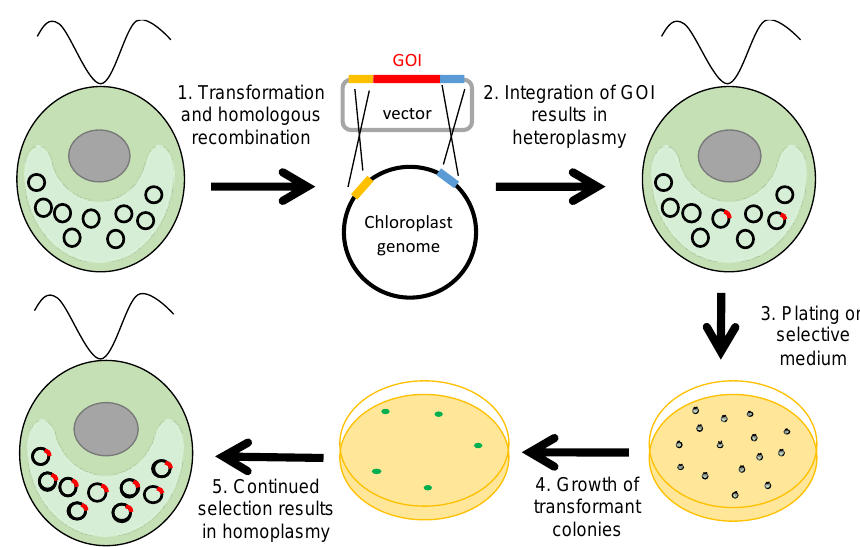
Figure 1. C. reinhardtii chloroplast transformation. The gene of interest (GOI) is integrated into some of the copies of the plastome by homologous recombination. Only cells containing at least one copy of the transgene and selectable marker will be able to survive on the selective medium, and will form colonies. At this stage it may be necessary to perform multiple rounds of single colony selection to attain homoplasmy.